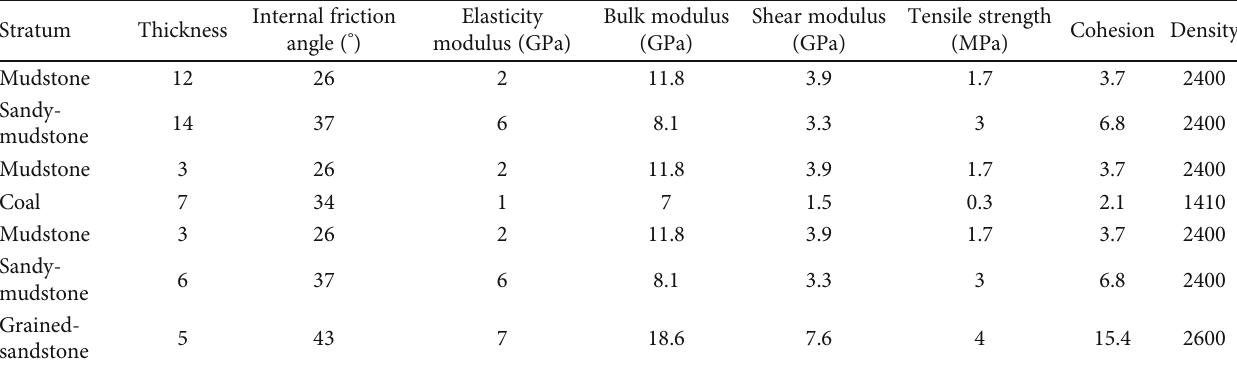
Figure 6: Morphological distribution of plastic zone at di ff erent tilt overburden Table 1: Mechanical parameters of the model.